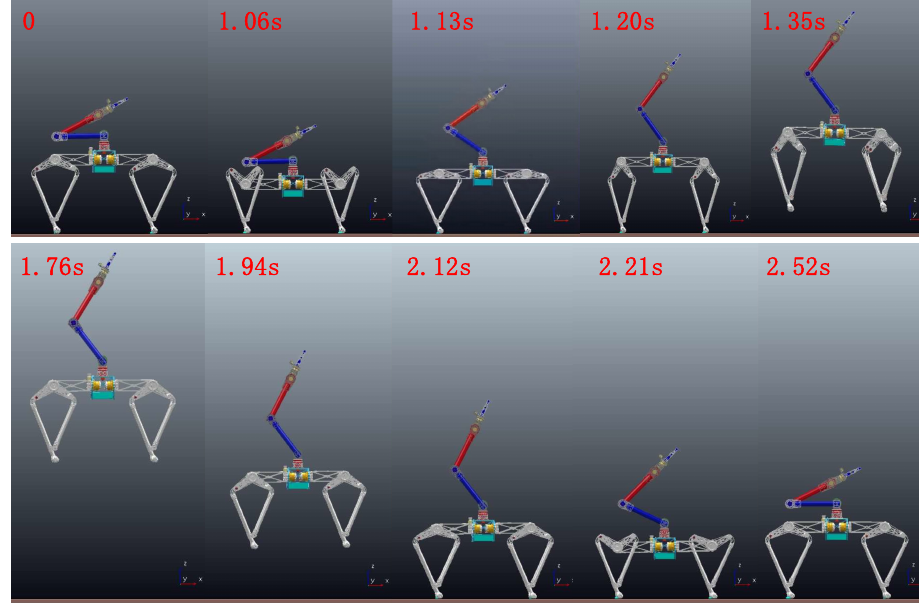
Figure 7. The snapshot of the single vertical jumping process.